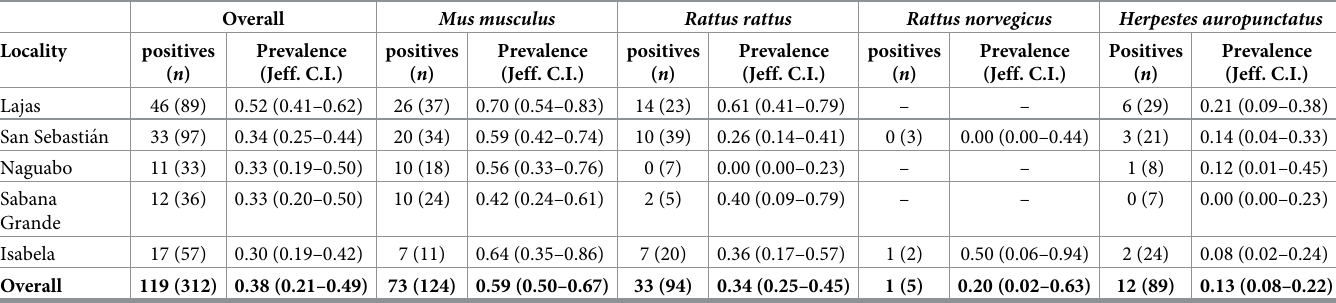
Table 1. Leptospira prevalence, with Jefferys confidence intervals, among invasive small mammals sampled from cattle farms in Puerto Rico during summer 2014 and 2015. Positives columns represent numbers of infected individuals (outside parenthesis) and total sample size ( n , in parenthesis). Jeff. C.I. = Jefferys Confidence